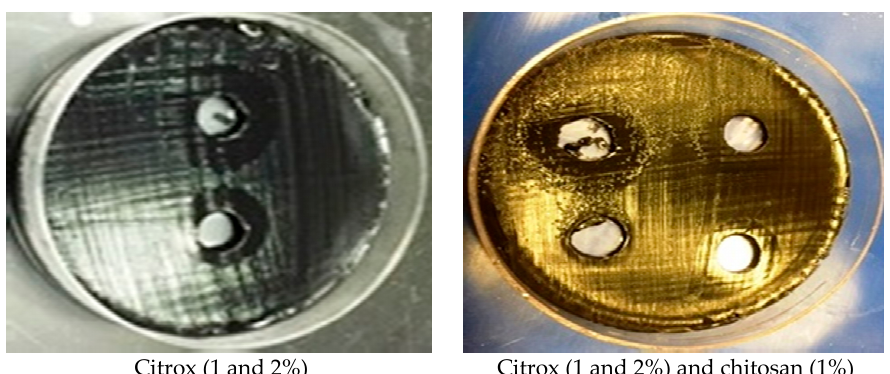
Figure 1. Effect of citrox solution at a concentrations of 1% and 2% citrox and 1% chitosan on Campylobacter jejuni. Campylobacter